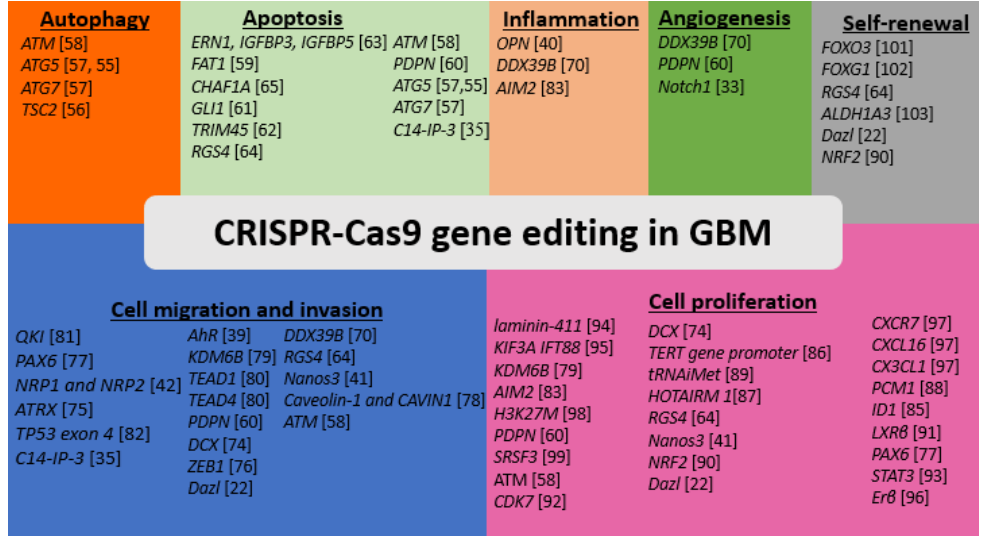
Figure 2. Application of CRISPR-Cas9 genome editing to identifying genes that correlate with different hallmarks of GBM. CRISPR-Cas9 mediated gene knockdown, knockout, and overexpression have been used for identifying several genes that have unique and overlapping roles in GBM development, progression, and recurrence. The listed genes with their references are the ones already edited using CRISPR-Cas9 genome editing technology in GBM research.